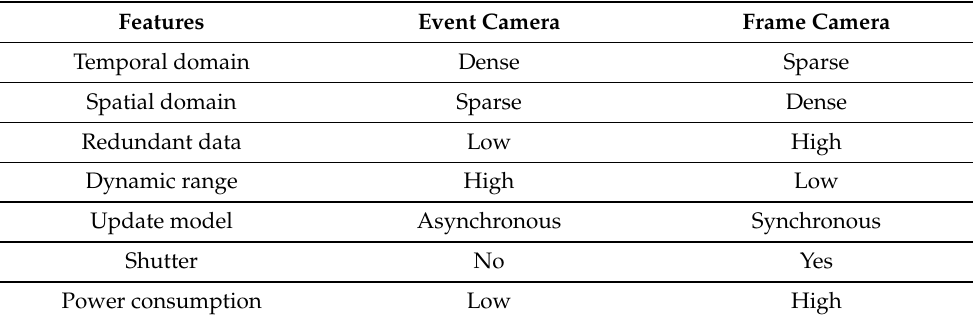
Table 1. The difference between event cameras and frame